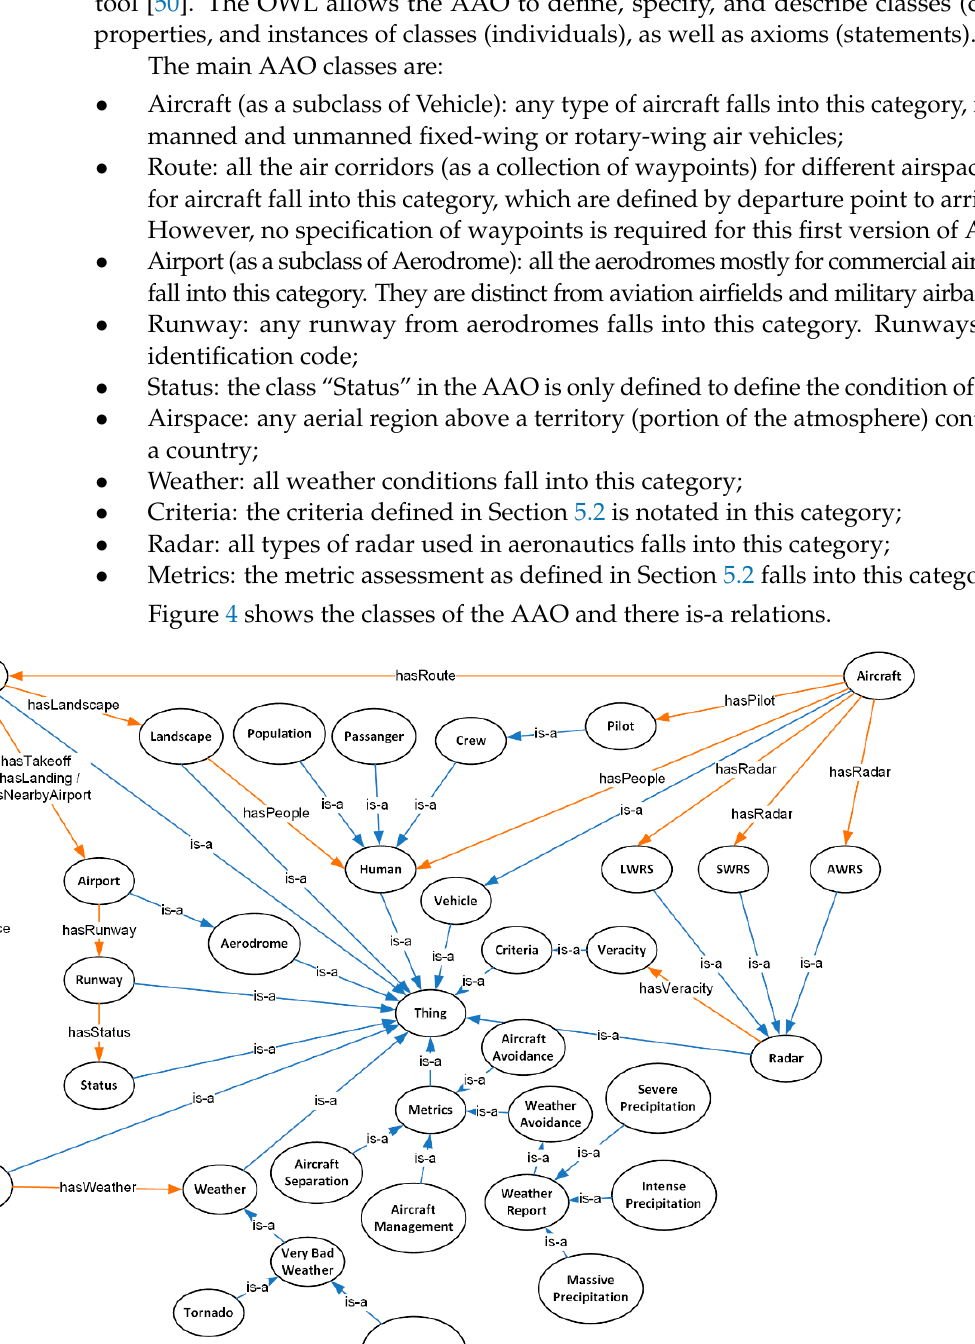
Table 5. AAO Components. Class